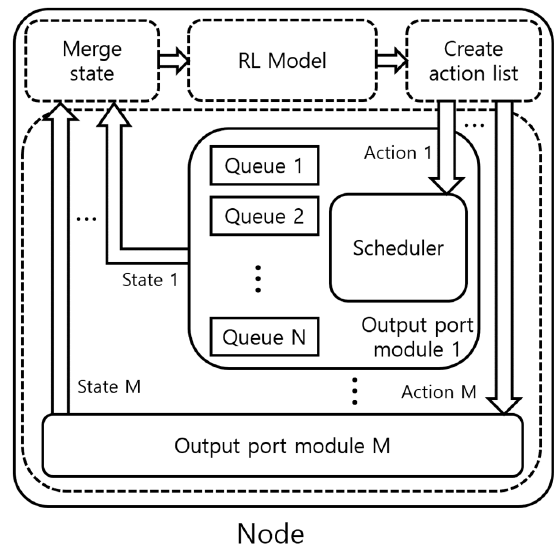
Figure 4. The learning process of MARL in the system.